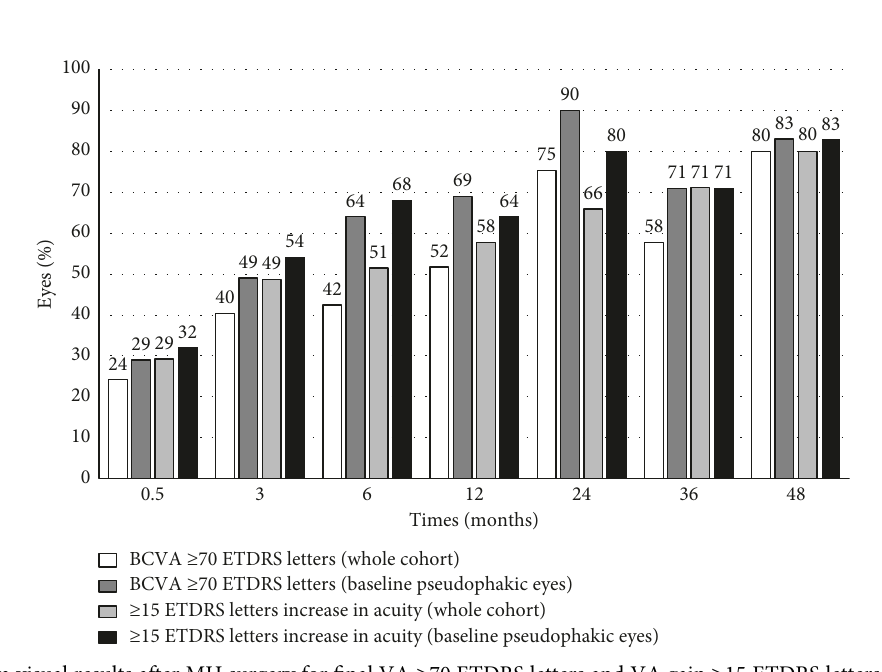
Figure 1: Long-term visual results after MH surgery for final VA ≥ 70 ETDRS letters and VA gain ≥ 15 ETDRS letters. BCVA ≥ 70 ETDRS letters (whole cohort). BCVA ≥ 70 ETDRS letters (baseline pseudophakic eyes). ≥ 15 ETDRS letters increase in acuity (whole cohort). ≥ 15 ETDRS letters increase in acuity (baseline pseudophakic